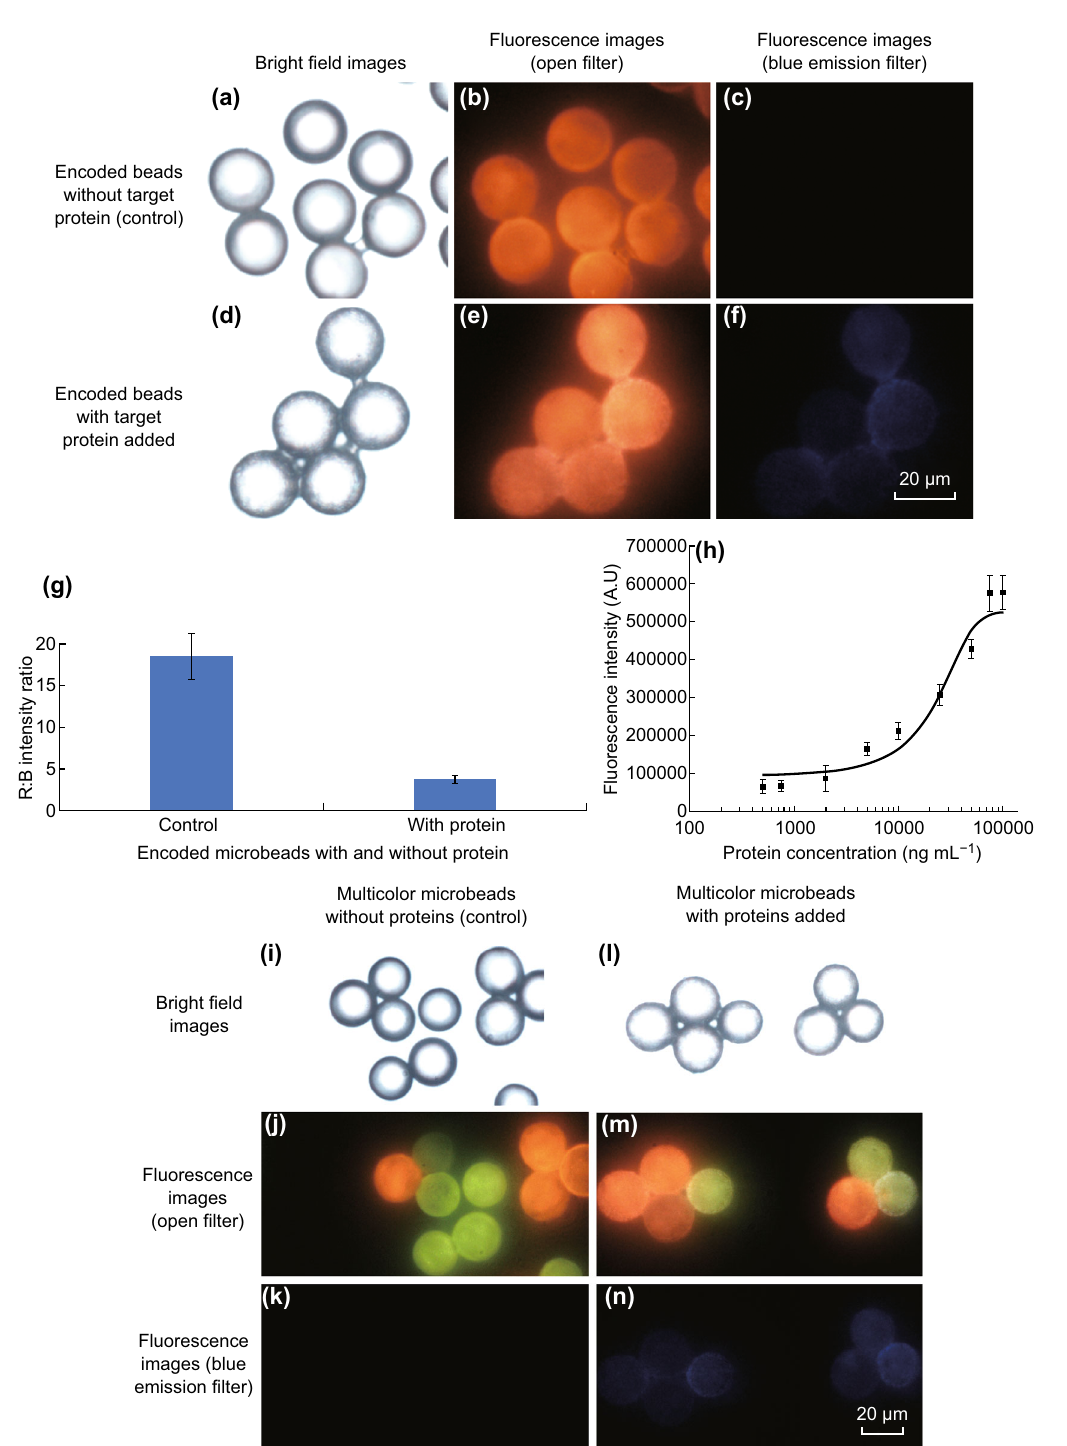
Fig. 7 Bright field images and corresponding fluorescent microscopy images of open filter and filter for collecting blue emissions (at 40 9 magnification). a, b, c without (control) and d, e, f with target HSA protein added. g Plot of R/B intensity ratio for encoded microbeads with and without protein target added for detection (data represent mean ± SD; n = 20 microbeads). h Calibration curve for quantitative detection of target HSA protein (data represent mean ± SD; n = 20 microbeads). Multiplex detection of target proteins HSA and hCRP using NaYF 4 :50%Yb1%Er and NaYF 4 :18%Yb2%Er30%Lu UCNPs-encoded multicolor microbeads. Bright field images and corresponding fluorescent images of open filter and filter for collecting blue emissions for encoded microbead-based detection for i, j, k without